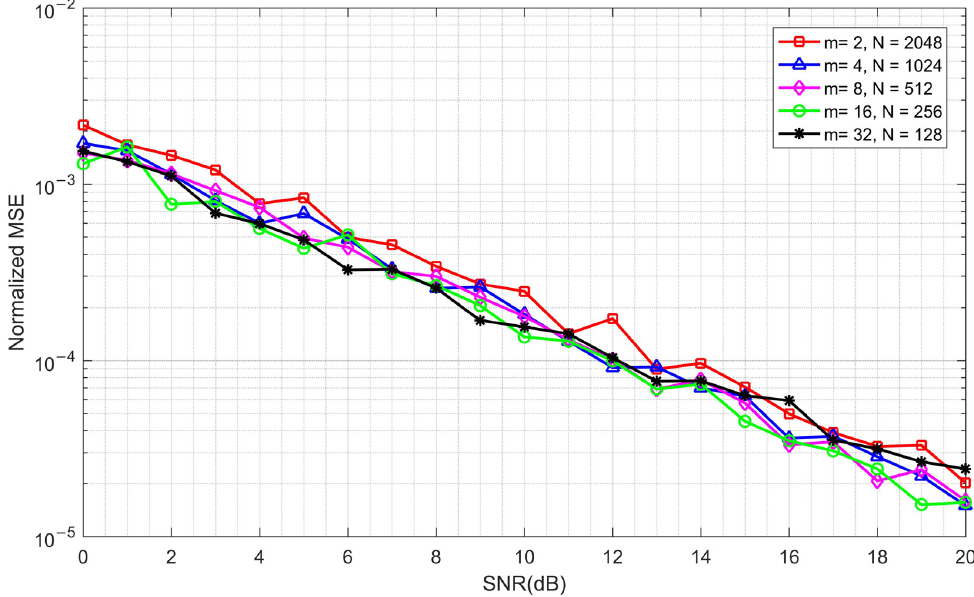
Figure 11. The normalized mean square error (MSE) with different m and N under a fixed CFO of 4 kHz.